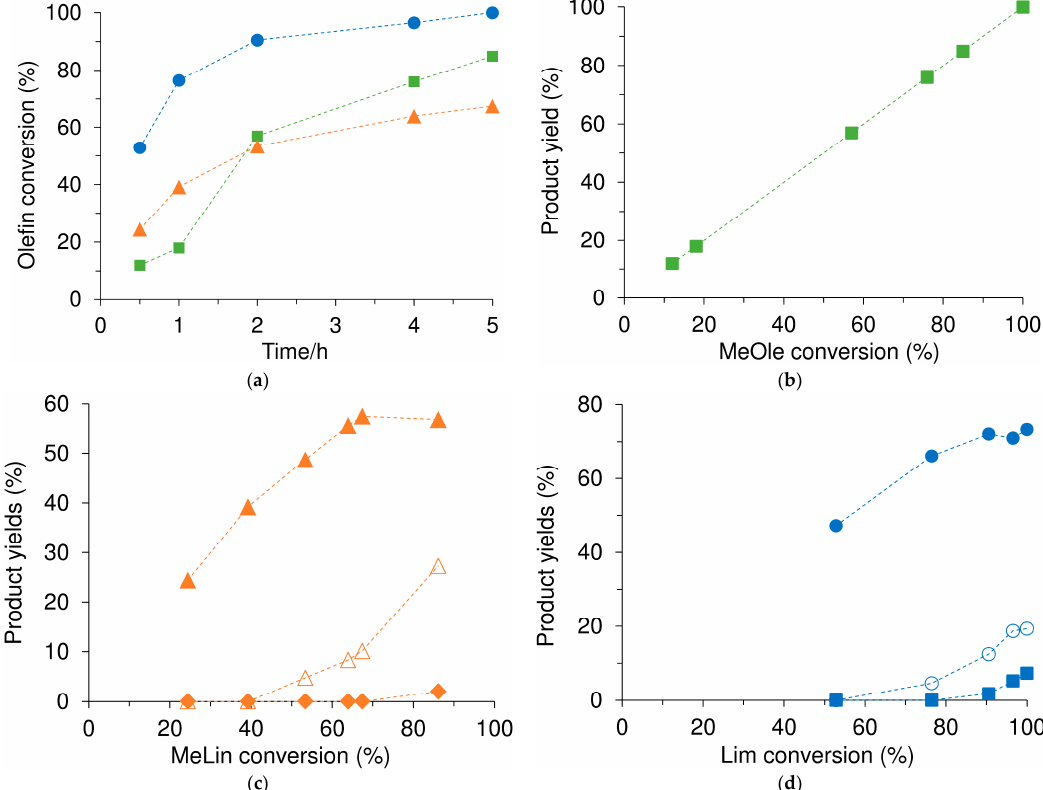
Figure 13. ( a ) Kinetic profiles of the reactions of MeOle ( ■ ), MeLin ( ▲ ), and Lim ( ● ) in the presence of 2 . Respective product yields: ( b ) MeOle reaction—MeOleEp ( ■ ); ( c ) MeLin reaction—MeLinEp ( ▲ ), MeLinDiEp ( △ ), and cyclization products ( ◆ ); ( d ) Lim reaction—LimEp ( ● ), LimDiEp ( ○ ), and LimDiol ( ■ ).